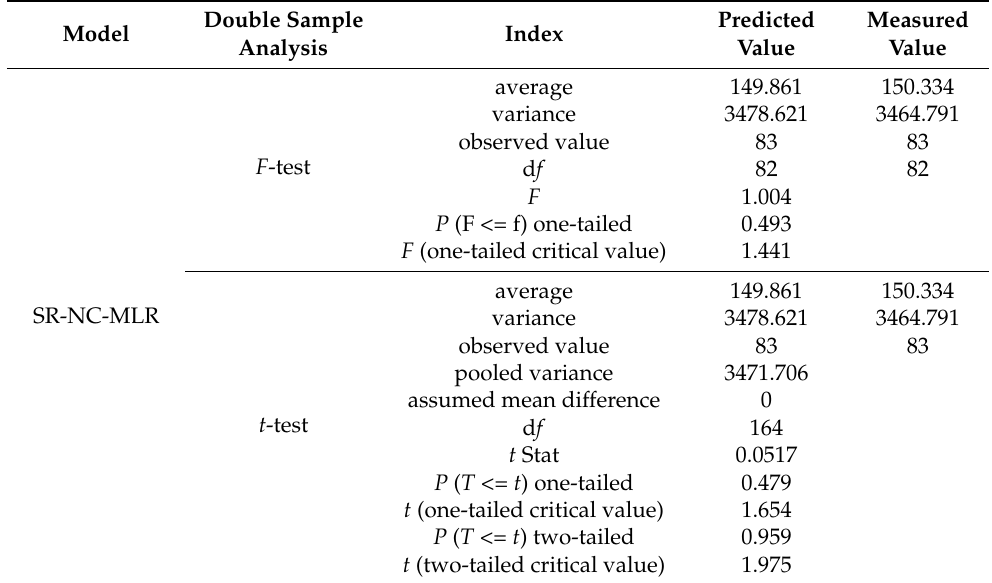
Table 5. F -test and t -test double sample analysis of